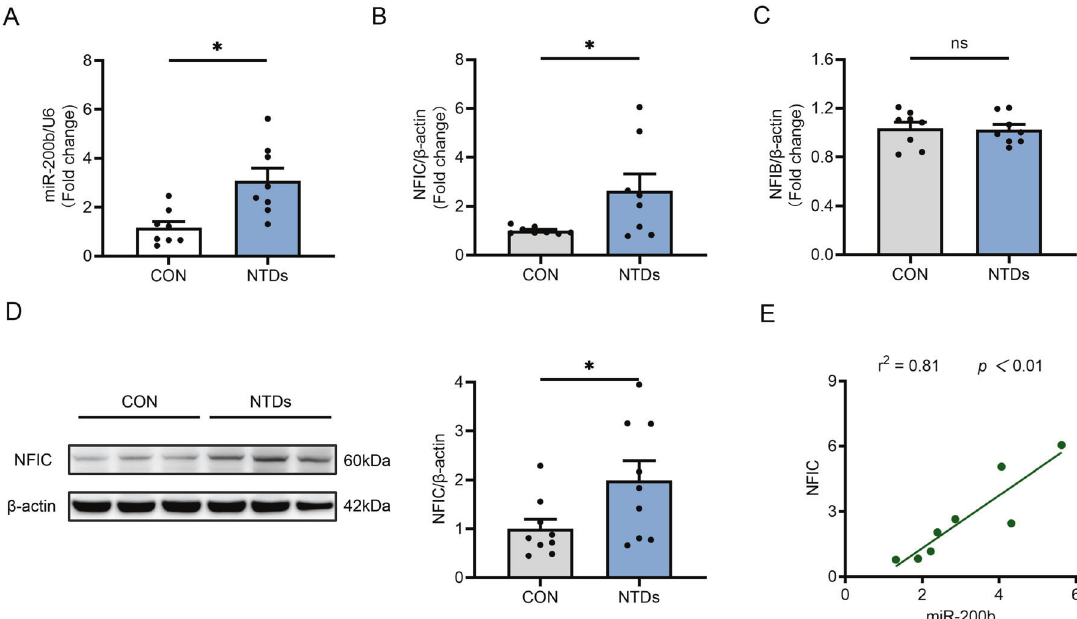
Fig. 1 Expression of miR-200b and NFIC in a mouse model of ATRA-induced NTDs. A Relative expression of miR-200b in normal and ATRA- induced NTD embryos at E9.5 ( n = 8). mRNA levels of NFIC ( B ) and NFIB ( C ) in E9.5 embryos from control and NTD groups ( n = 8). D Protein abundance of NFIC in E9.5 mouse embryos ( n = 9). E RNA expression correlation analysis for miR-200b and NFIC in NTD mouse embryos, as shown in the panel. The bar graph shows quantitative data from all experiments, which were independently performed in triplicate. * P < 0.05 vs. control group, “ ns ” represents no signi fi cance, compared to the control